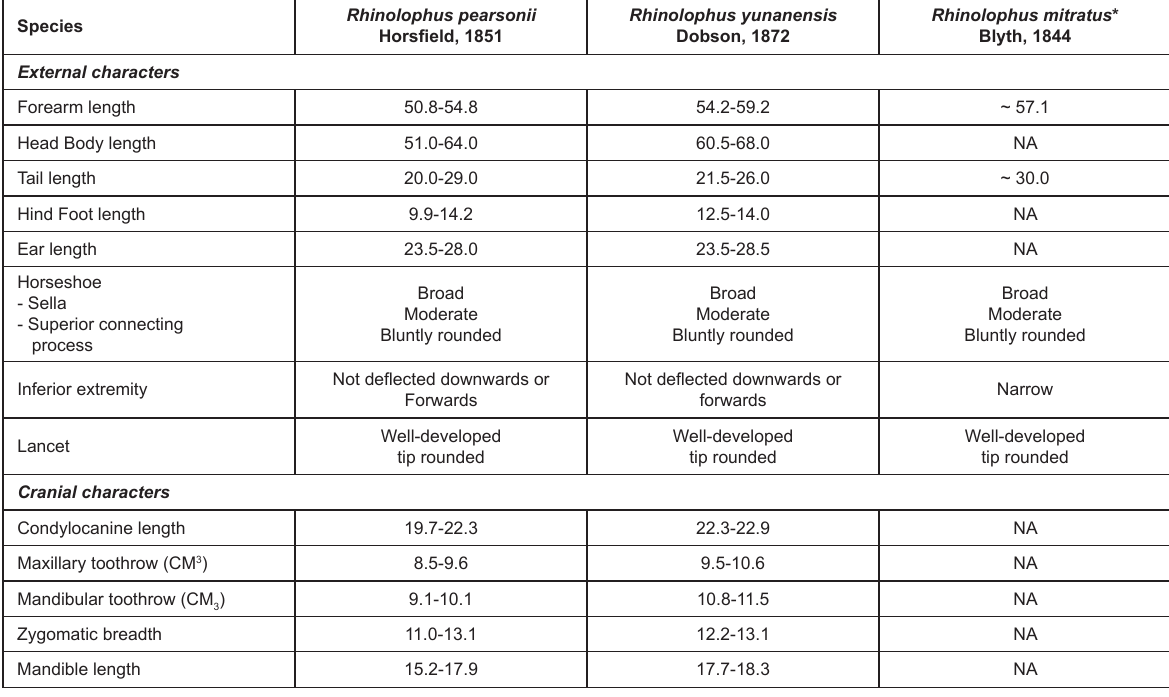
Table 4.4. (Contd..). Diagnostic morphological characters of twenty species of the genus Rhinolophus Lacépède, 1799 present in South